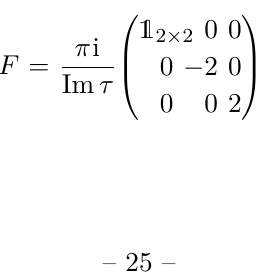
Figure 3. Dependence of the magnitude of the Yukawa couplings Y orange dashed, green dotted and red dash-dotted curves represent There is an exponential suppression with Im τ that depends on the “distance” between the wave functions α , i.e. the Im τ dependence is more pronounced for larger b